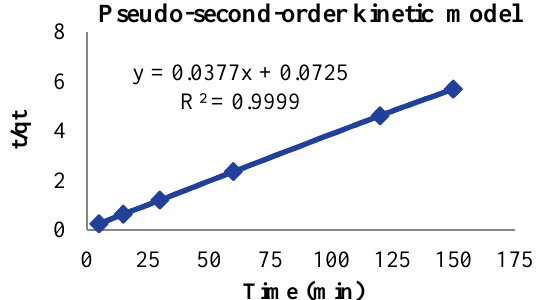
Figure 11. Pseudo-second-order kinetic model of humic acid (HA) absorption on activated carbon (AC) (initial concentration = 25 mg/l, pH = 6-7.5, T = 25